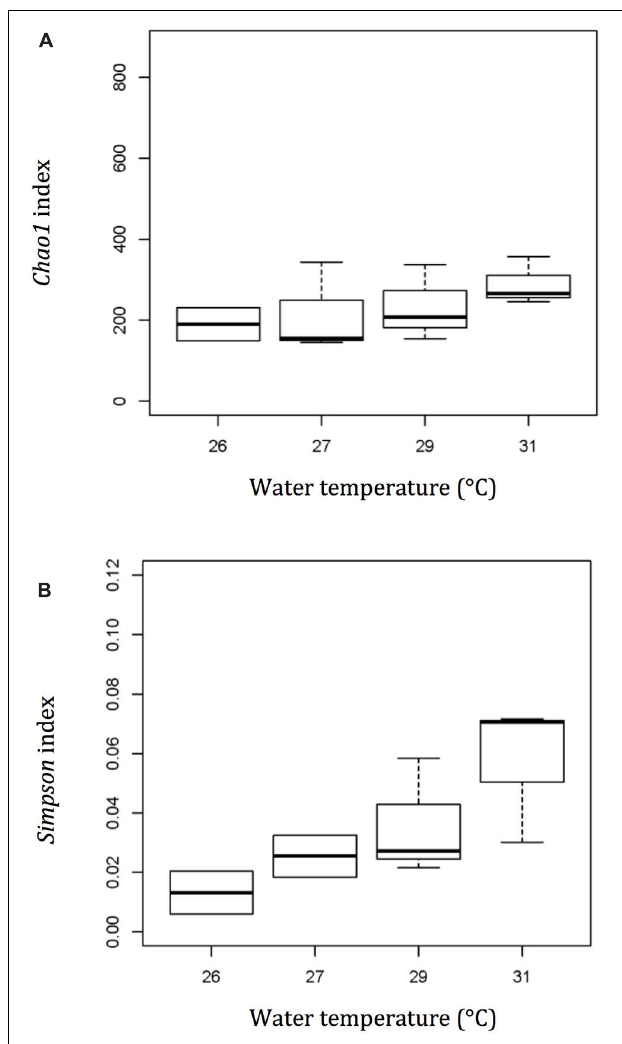
FIGURE 4 | Diversity and richness index – Chao1 (A) and Simpson (B) show a more diverse bacterial community in the mucus layer of thermally stressed Acropora muricata at a higher temperature. Plot – line represents median values, boxes represent 75% percentile and whiskers represent the highest and lowest